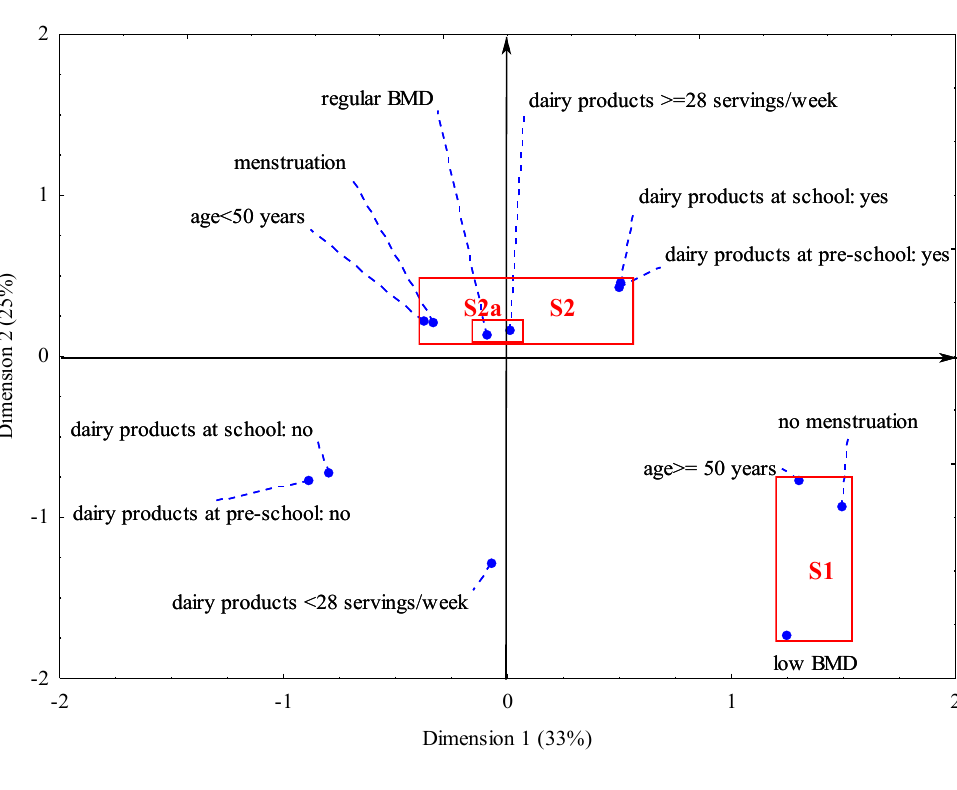
Figure 1. Graphical presentation of the relationship between risk factors for osteoporosis and bone mineral density in women. () in brackets are the given explained inertia in two dimensions; areas marked by rectangles and signed S1 and S2 point two clusters grouping features correlated with each other; Notes: ―dairy products ≥ 28 servings/week‖— consumption of dairy products ≥ 28 servings/week; ―dairy products <28 servings/week‖ — consumption of dairy products < 28 servings/week; ―dairy products at pre-school: yes‖— daily consumption of dairy products during pre-school period; ―dairy products at pre-school: no‖—lack of daily consumption of dairy products during pre-school period; ―dairy products at school: yes‖—daily consumption of dairy products during school period; ―dairy products at school: no‖—lack of daily consumption of dairy products during school